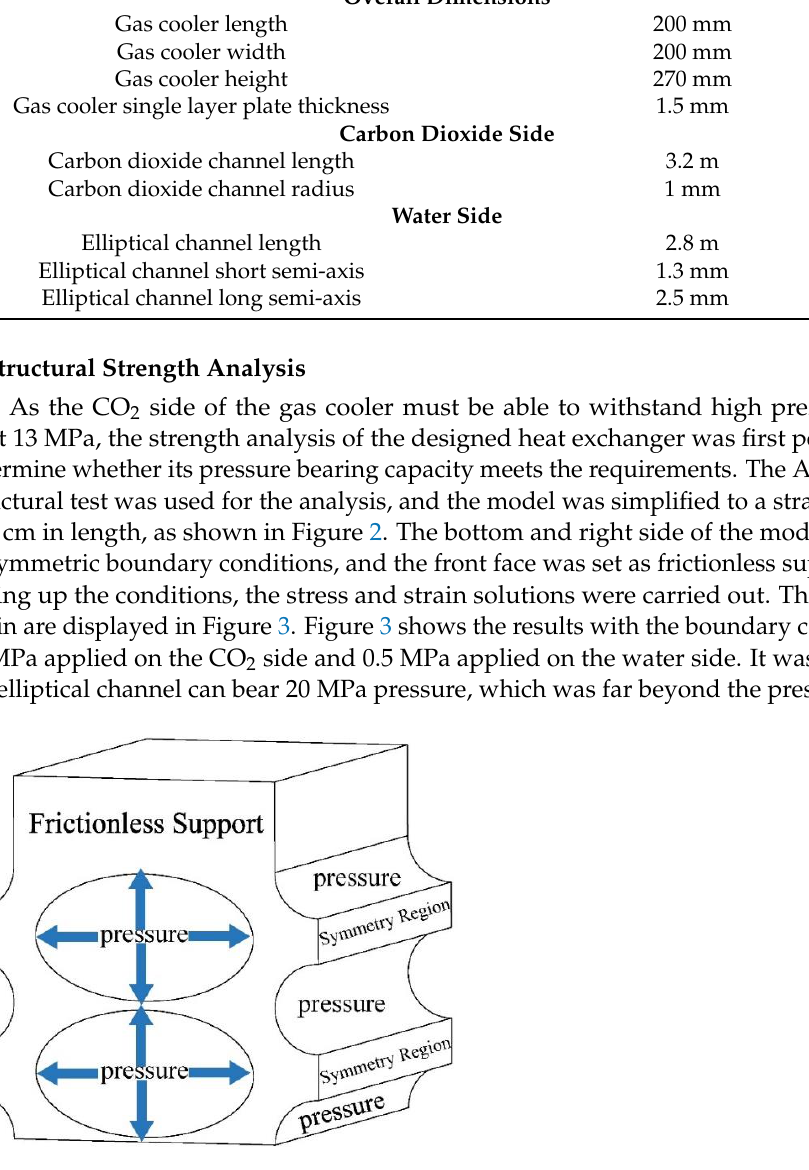
Table 1. Important dimensions of the gas cooler.